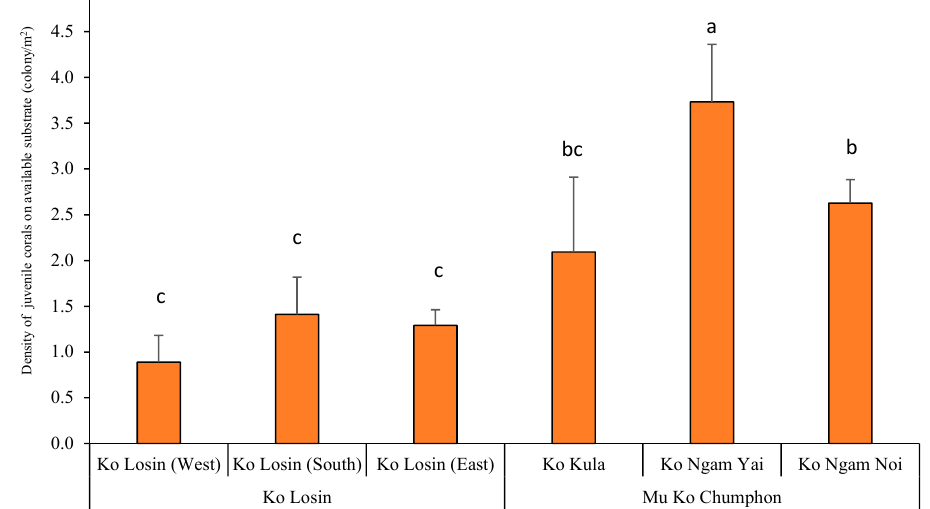
Figure 9. Densities of juvenile corals (mean ± SD) on available substrate at the study sites (one-way ANOVA, p < 0.05). Different letters above bars indicate statistical differences ( p < 0.05), as determined by Tukey’s HSD.